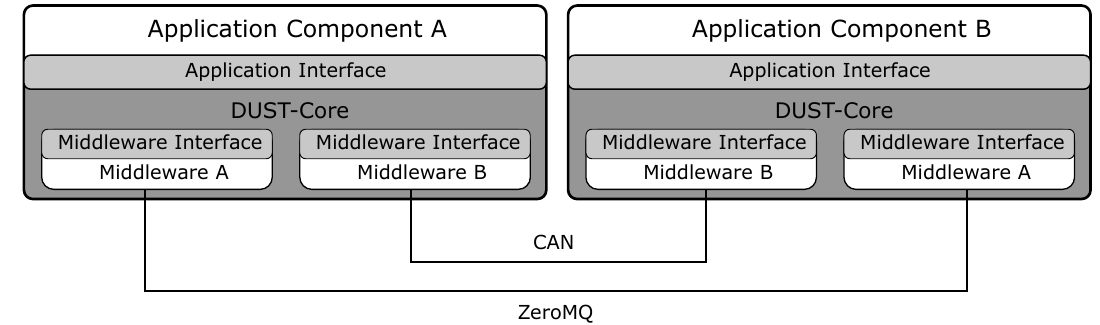
Figure 8. The middleware is transparent to the application